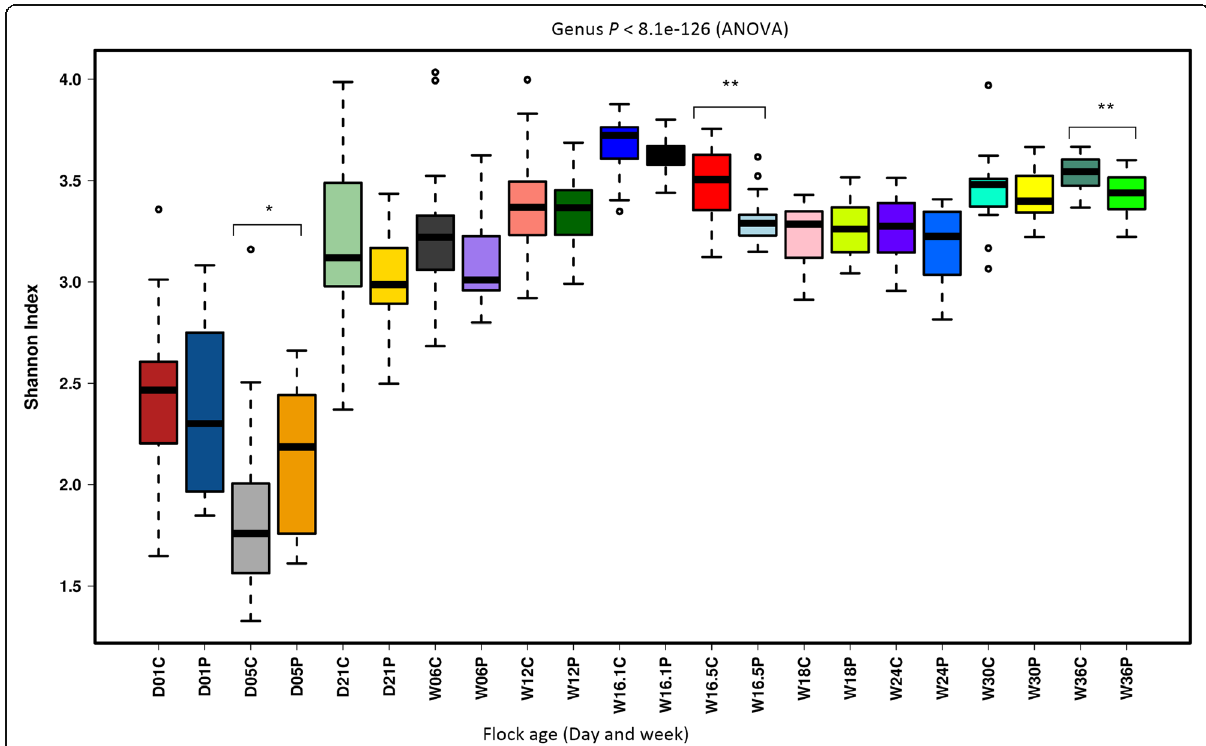
Fig. 6 Alpha diversity of gut microbiota affected by probiotic supplementation and flock age. For direct comparison, alpha diversity at each sampling period was compared between the control and probiotic supplemented flocks. Letters “ D ” and “ W ” refer to flock age in a day and week post-hatch, while letters “ C ” and “ P ” refer to control and probiotic supplemented flock. Alpha diversity was measured at the genus level using the Shannon index in Calypso software that takes into account both the richness and evenness of microbial communities. Asterisks (* and **) show P values at 0.01 and 0.001, respectively. As per feed management guidelines of Hy-Line International, a different type of feed was introduced at 1,